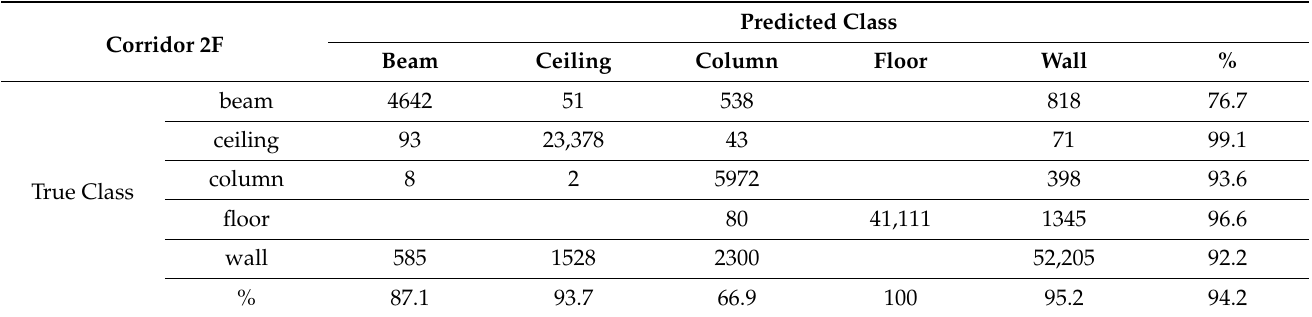
Table 5. Confusion matrix for corridor 2F. The overall accuracy is 94.2%.